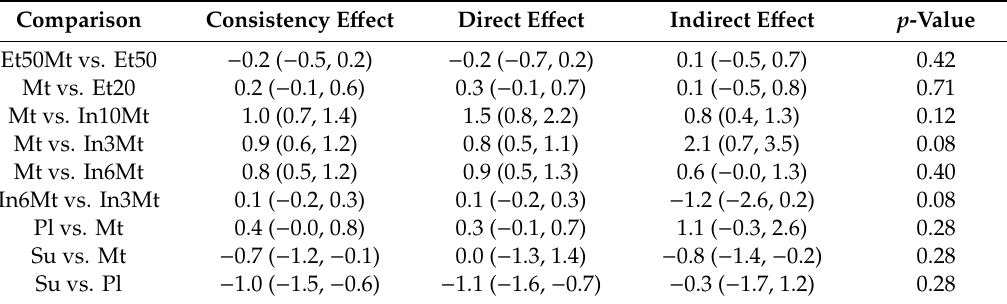
Table 4. Results of node-splitting